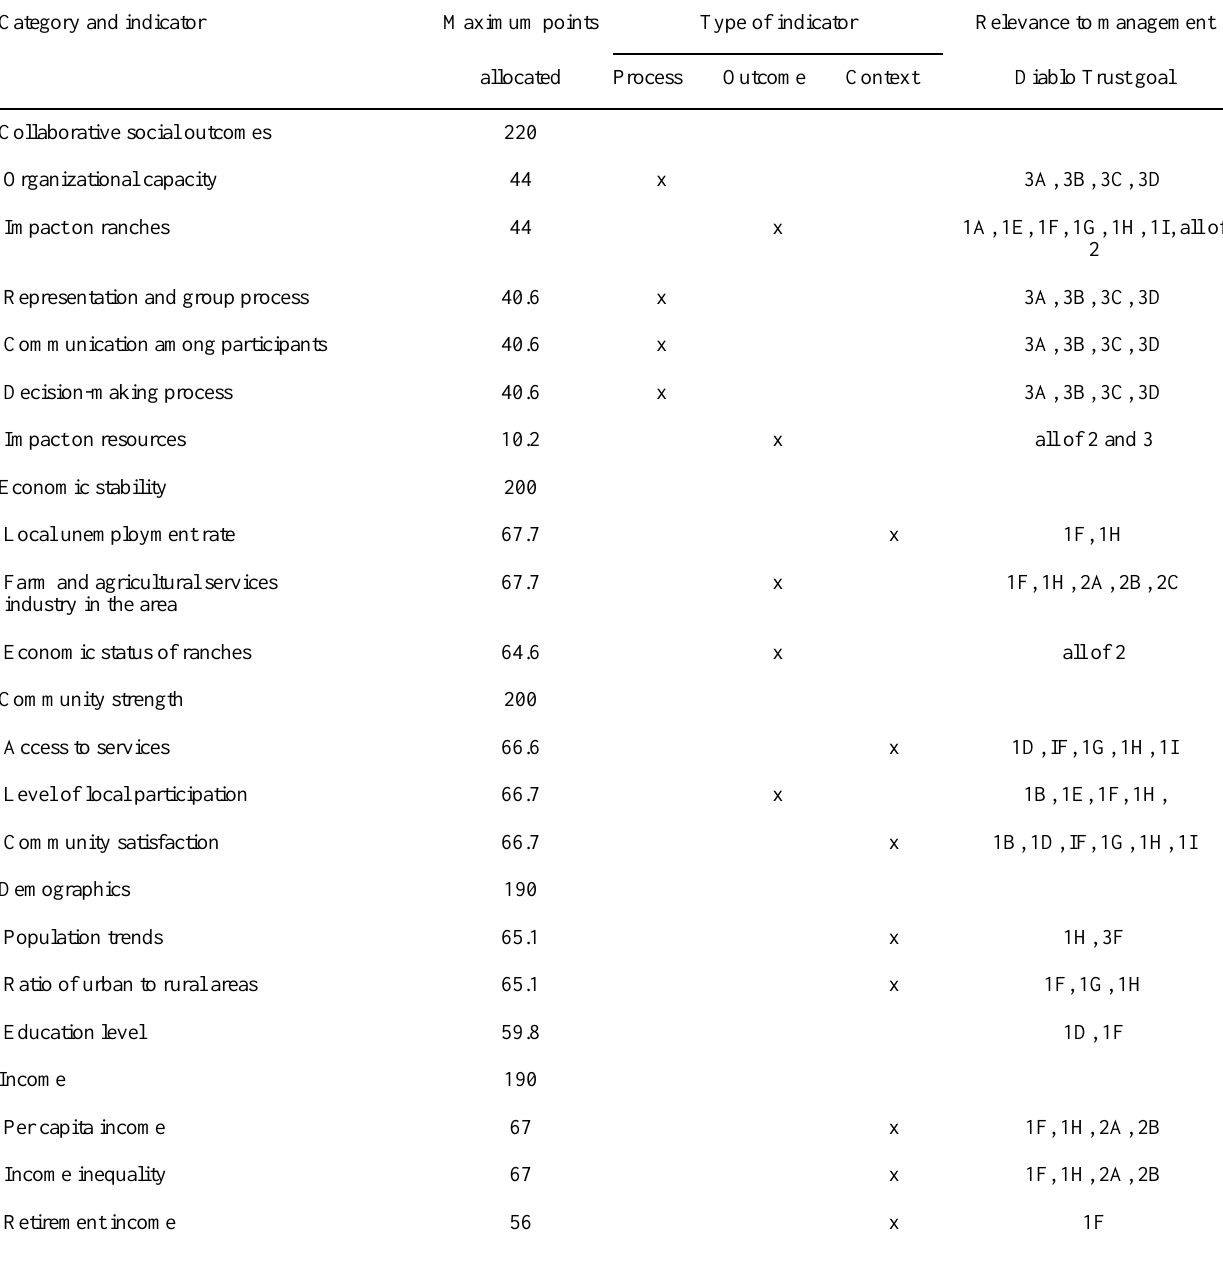
Table 5. Social branch indicators selected through the participatory approach to develop the holistic ecosystem health indicator for the Diablo Trust collaborative organization. The maximum points allocated are the estimated weighted points assigned to each category and eighteen indicators out of the total 1000 points. Each indicator may provide information related to the process, outcome, or context of the collaborative organization. The relevance of the indicators to the management goals was classified according to the Diablo Trust three-part holistic goal (Table